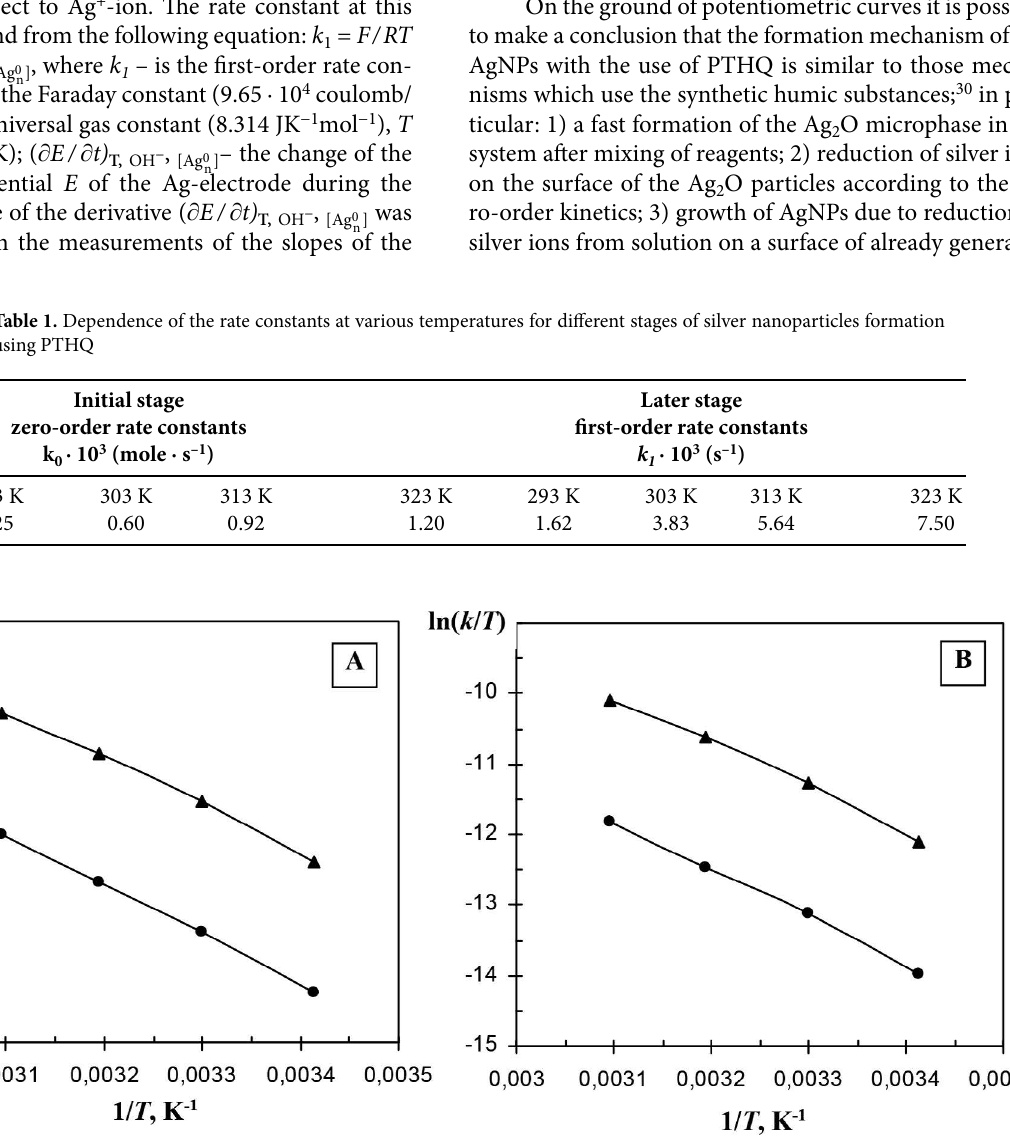
Fig. 5. The Arrhenius (A) and Eyring (B) plots of the silver nanoparticles formation for the initial ( • ) and later ( ▲ ) stages using the PTHQ